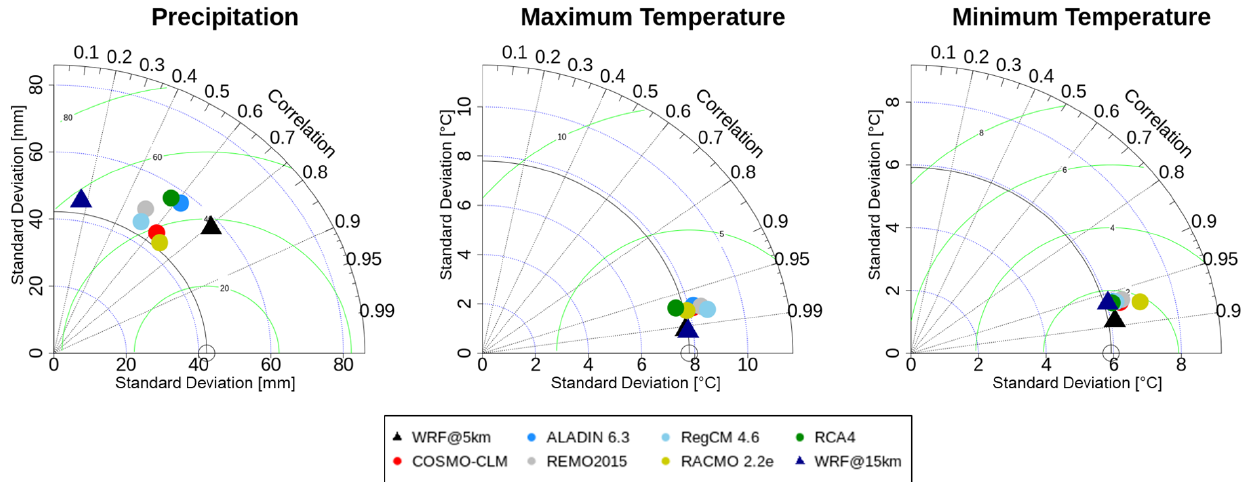
Figure 1. Taylor diagrams comparing the model performances in reproducing the monthly values of the meteorological variables in relation to the E-OBS reference data for the study period 1980–2009 and the whole study area.